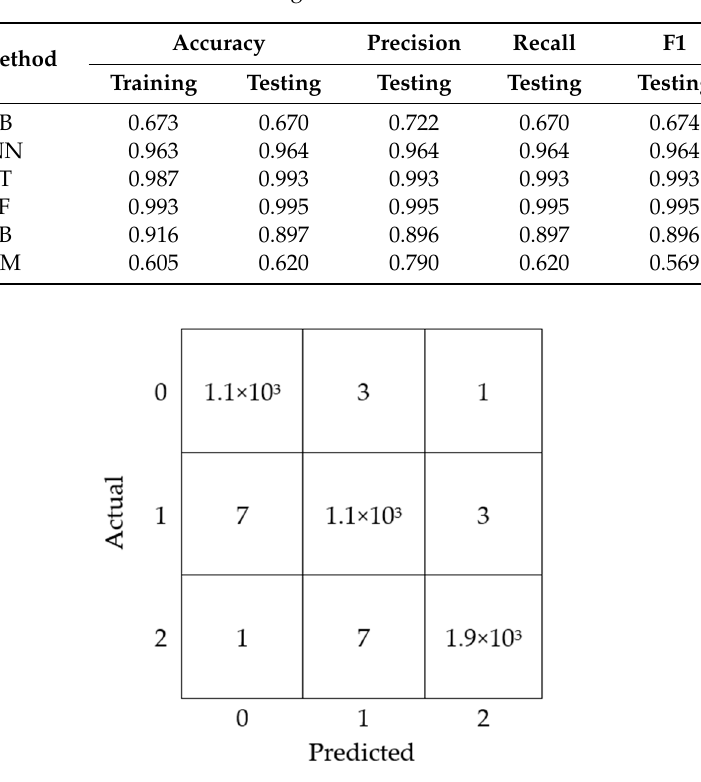
Table 6. Building classification results.